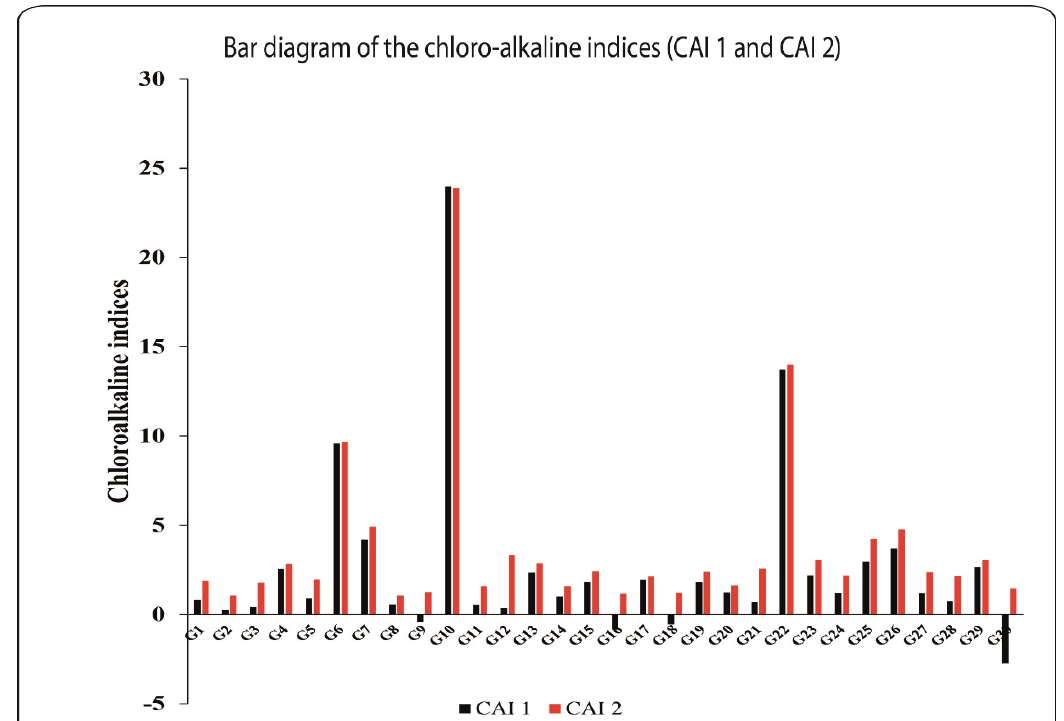
Figure 5. Chloro-alkaline indices (CAI 1 and CAI 2 ) for the groundwater samples.